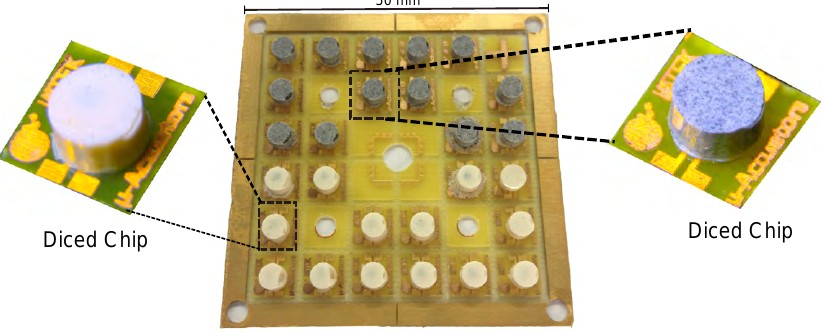
Figure 8. Fully processed substrate with 14 pure epoxy encapsulated transformer chips (white) and 13 magnetic epoxy encapsulated transformer chips